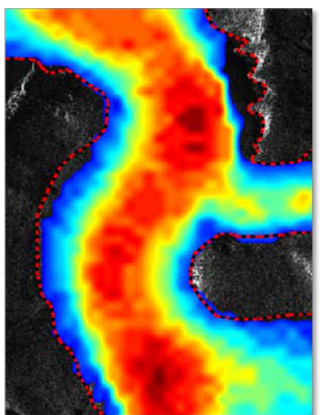
Fig.1. Improved glacier motion estimation result from a part of the surging area of the Taku Glacier. Red dash line: the manually extracted boundaries of the glacier. Although the velocity map already gives a good approximation of the whole glacier surface, there are still some gaps left (e.g. in the upper right part of the